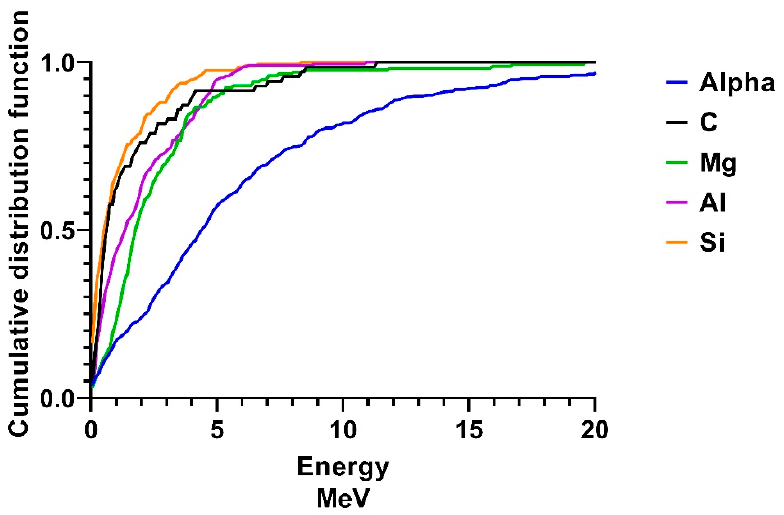
Figure 3. Cumulative distribution function of kinetic energy of secondary particles generated by 200 protons irradiated on silicon.